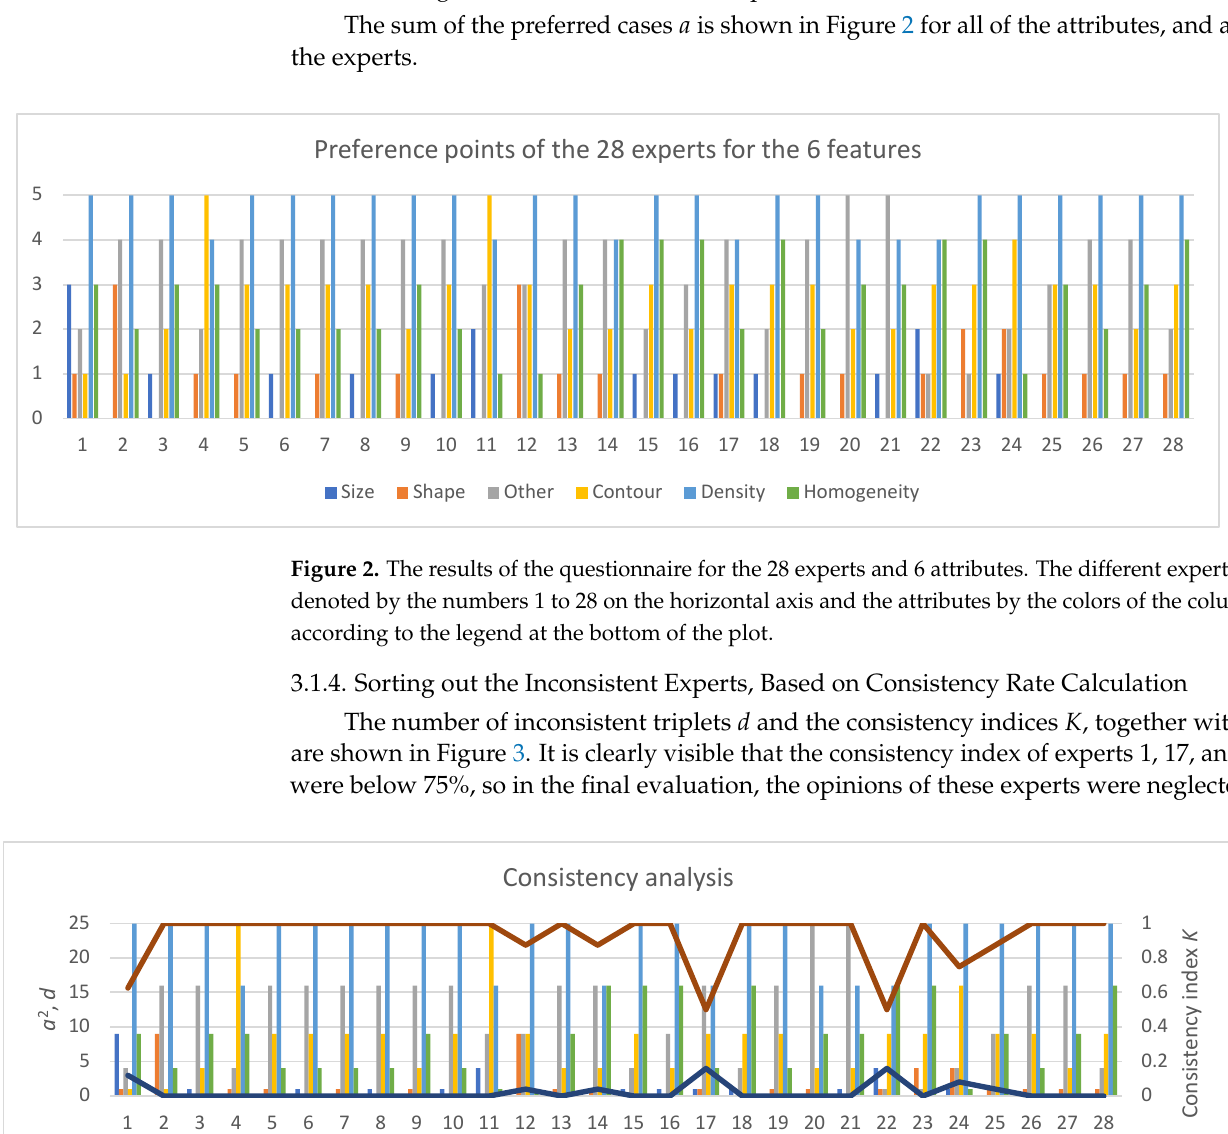
Figure 4. The preference rates for the 28 experts and 6 attributes. In the upper subplot the different experts are denoted by numbers 1 to 28 on the horizontal axis, the attributes by the color of the columns according to the legend at the bottom of the plot. The lower subplot contains the same information, but sorted according to the attributes. The inconsistent experts 1, 17, and 22 are denoted by a red column with black borderlines, the others have different colors in the lower subplot. 3.1.6. Determining the Ranks of the Attributes in Decision Making The preference rates were converted to rankings, according to Section 2.6.6. The rank- ings of the consistently answering experts are shown in Figure 5, together with the cumu- lative ranking of the attributes. The standard deviation of the rankings were   = 0.57 ,   = 1.04 ,   = 1.02 ,   = 0.95 ,   = 0.37 , and   = 1.07 . It can be seen that the ranking of density as the most important attribute has a very small deviation. In addition, the ranking of size as the least important attribute had a rather low